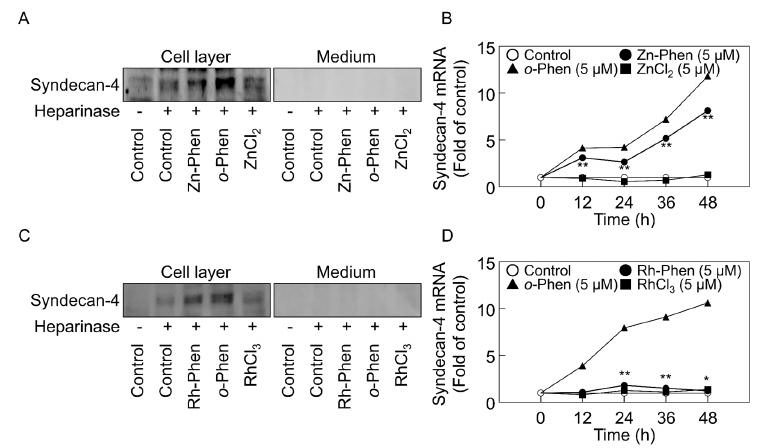
Figure 2. Effects of o -Phen, Zn-Phen, Rh-Phen, ZnCl 2 , and RhCl 3 on syndecan-4 expression in vascular endothelial cells. Bovine aortic endothelial cells were treated with Zn-Phen, o -Phen, or ZnCl 2 ( A , B ) and Rh-Phen, o -Phen, or RhCl 3 ( C , D ) at 5 µM each at 37 °C for 24 h ( A , C ) or for 12, 24, 36, and 48 h ( B , D ). Syndecan-4 core protein and mRNA were analyzed by Western blot and real time RT-PCR, respectively. Values are means ± S.E.M. of four samples. * p < 0.05; ** p < 0.01 vs. control.